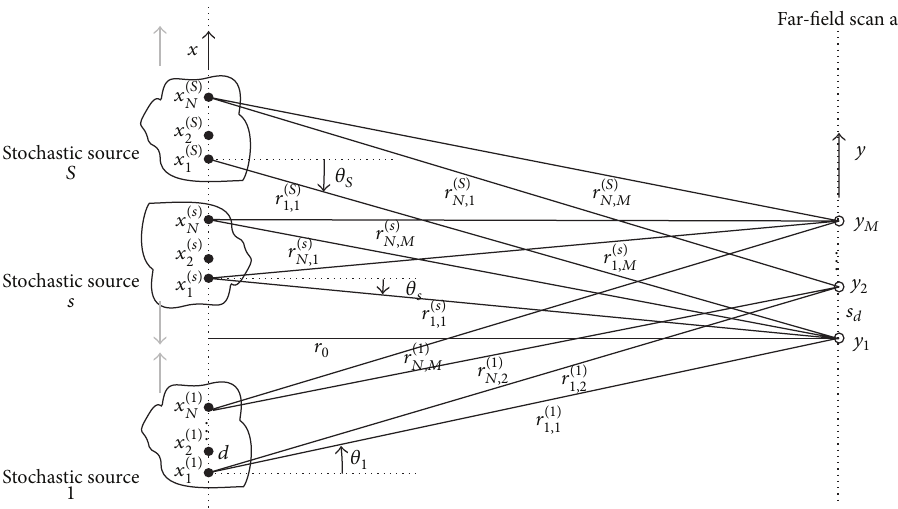
Figure 1: The position of stochastic source in azimuth plane with respect to the location of EM field sampling points in the far-field scan area.